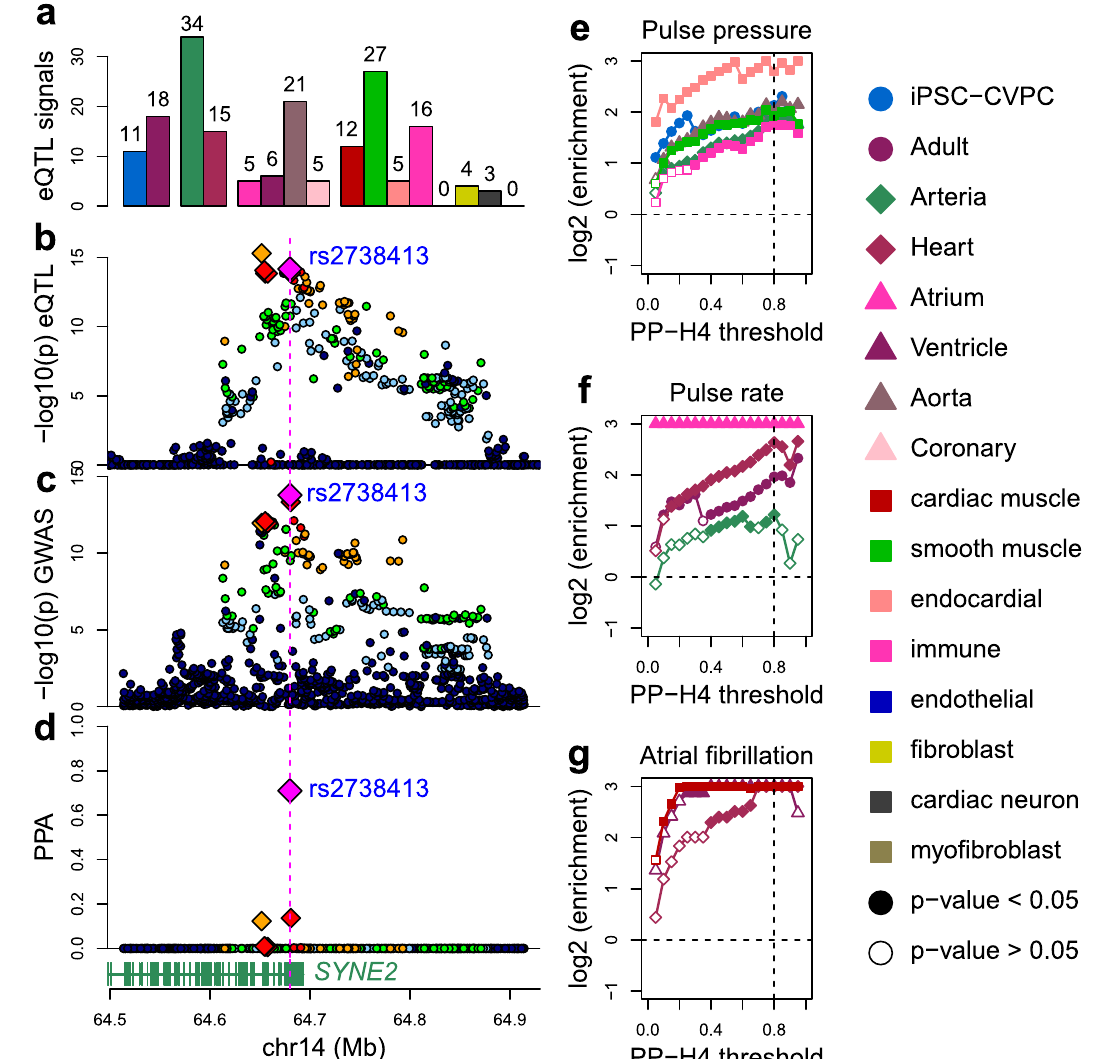
Fig. 5 | Colocalization between spatiotemporal eQTLs and cardiac GWAS. a BarplotsshowingthenumberofspatiotemporaleQTLsignalsthatcolocalizewith cardiac GWAS signals. We observed 51 eGenes and 21 eIsoforms that were asso- ciated with one or more spatiotemporal categories colocalize with GWAS traits. Colors represent cardiac stage, organ, tissue, and cell type as described in the legendontheright. b – d Plotsshowing( b ) − log 10 ( p -value)forcardiacmuscle-eQTL signal for SYNE2 , c the GWAS signal for atrial fi brillation and d the PPA of each variant in the colocalization. The lead variant (i.e., the variant with highest PPA of beingcausalforboththeeQTLandGWASsignals)isshownasamagentadiamond: